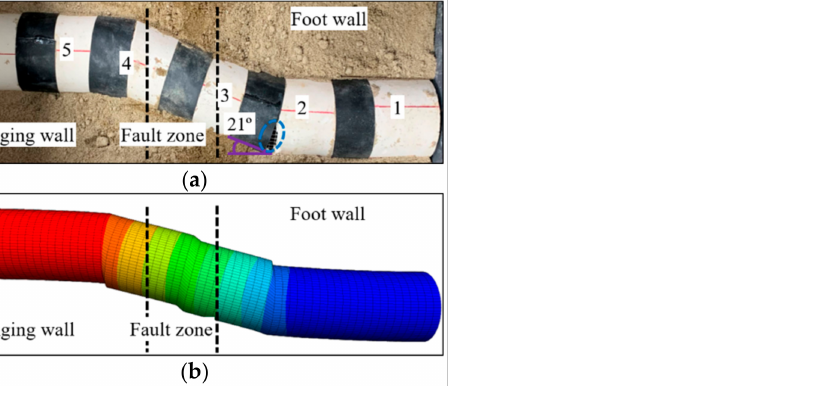
Figure 17. Failure pattern of the tunnel for numerical and model experiments. ( a ) model experiment; ( b ) numerical simulation.